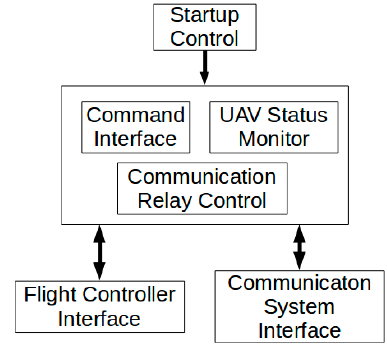
Figure 11. Block diagram of mission control software.